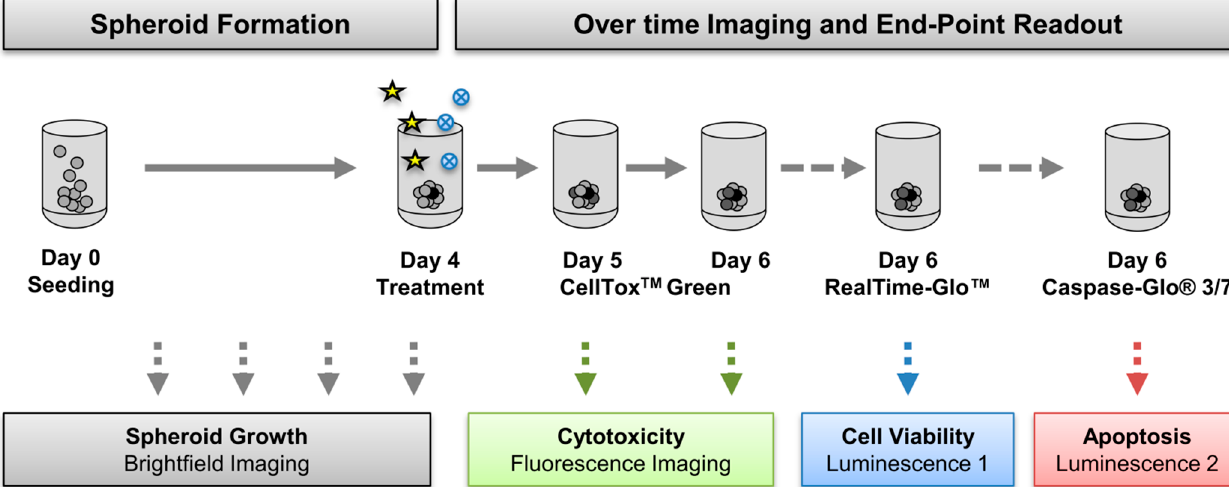
Figure 3. Multi-content 3D readout to test drug combinations. OvCa cells were seeded in ultra-low attachment (ULA) plates and spheroids formed four days before treatment. Daily imaging using NYONE ® Scientific (SYNENTEC) recorded the formation process and spheroid morphology and growth over time. On day four, spheroids were treated with cisplatin (asterisks) in absence or presence of metalloprotease inhibitors (blue circles), as described. To allow multiplex readout of three consecutive assays in one 96-well plate, the real-time fluorescence-based cytotoxicity assay CellTox TM Green was first applied on day five and imaged twice: day five = 24 h after treatment, and day six = 48 h after treatment. Next, cell viability and caspase activation were measured using two different luminescent assays to allow for multiplexing using different filters.